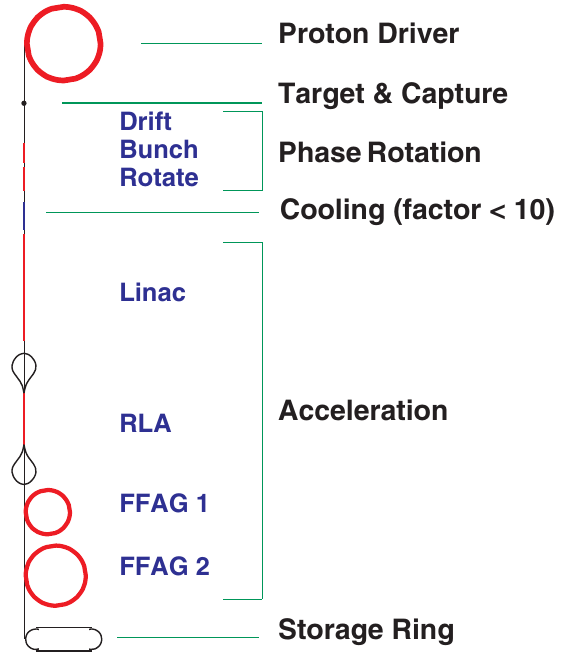
FIG. 1. (Color) Schematic of a neutrino factory facility.